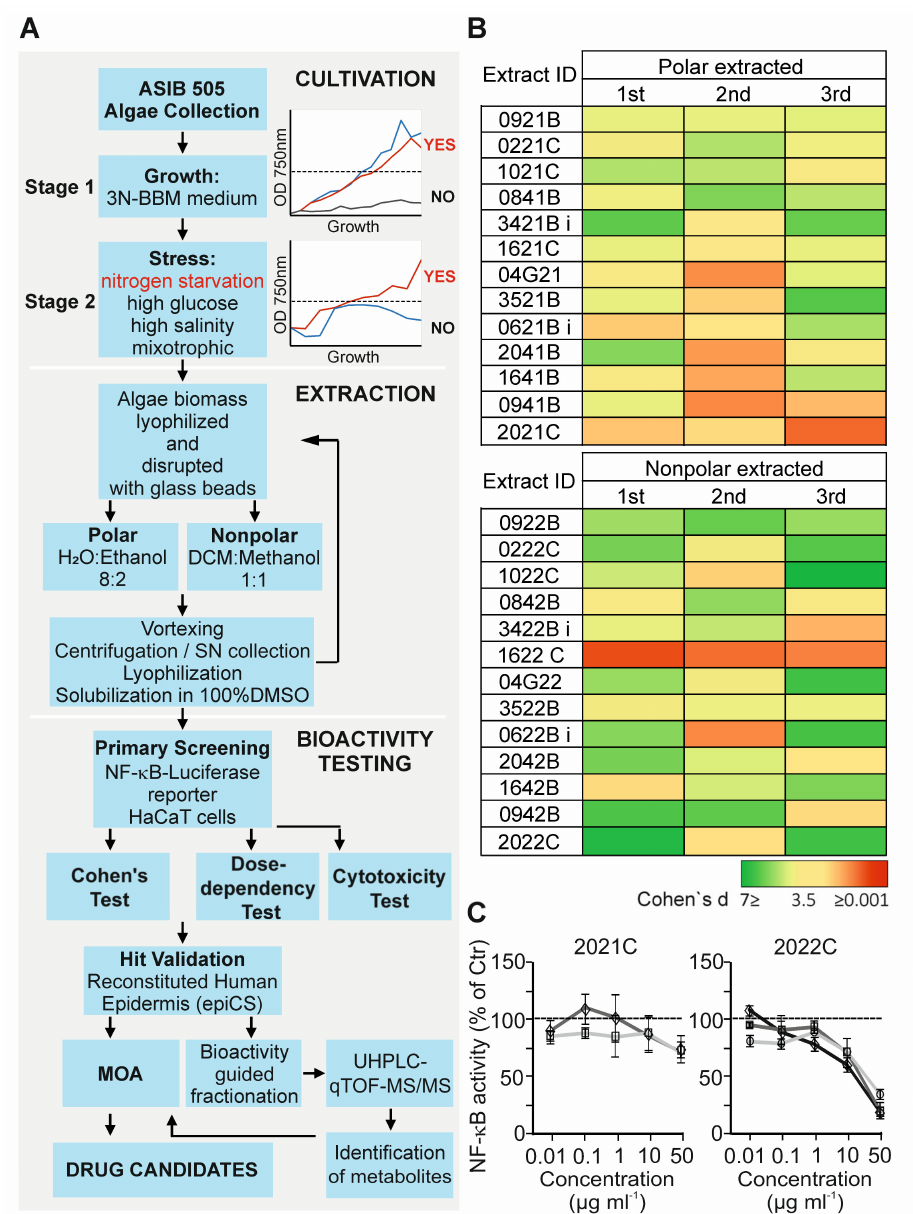
Figure 1. Anti-inflammatory activity screening of algae extracts. ( A ) Workflow of the screening procedure for the identification of anti-inflammatory metabolites from soil algae. In the cultivation box, the growth curves represent examples of selected strains cultivated under standard conditions (Upper) or nitrogen deprivation (Lower); DCM, dichloromethane; MOA, mode of action. ( B ) Heatmap of effect sizes (Cohen’s d, with higher value indicating repression and lower value indicating increase in reporter activity) of NF- κ B reporter inhibition by algae extracts in TNF α -stimulated HaCaT cells. Biological replicates are named 1st, 2nd, and 3rd, and are presented as the mean of the technical replicates ( n = 3). ( C ) Dose-dependent anti-inflammatory effects of polar (2021C) and nonpolar (2022C) C. zofingiensis extracts in HaCaT cells. NF- κ B activity in DMSO-treated cells is taken as 100%. Each curve represents an independent experiment. Values are mean ± SD of technical replicates ( n = 3); Ctr, control (DMSO + TNF α